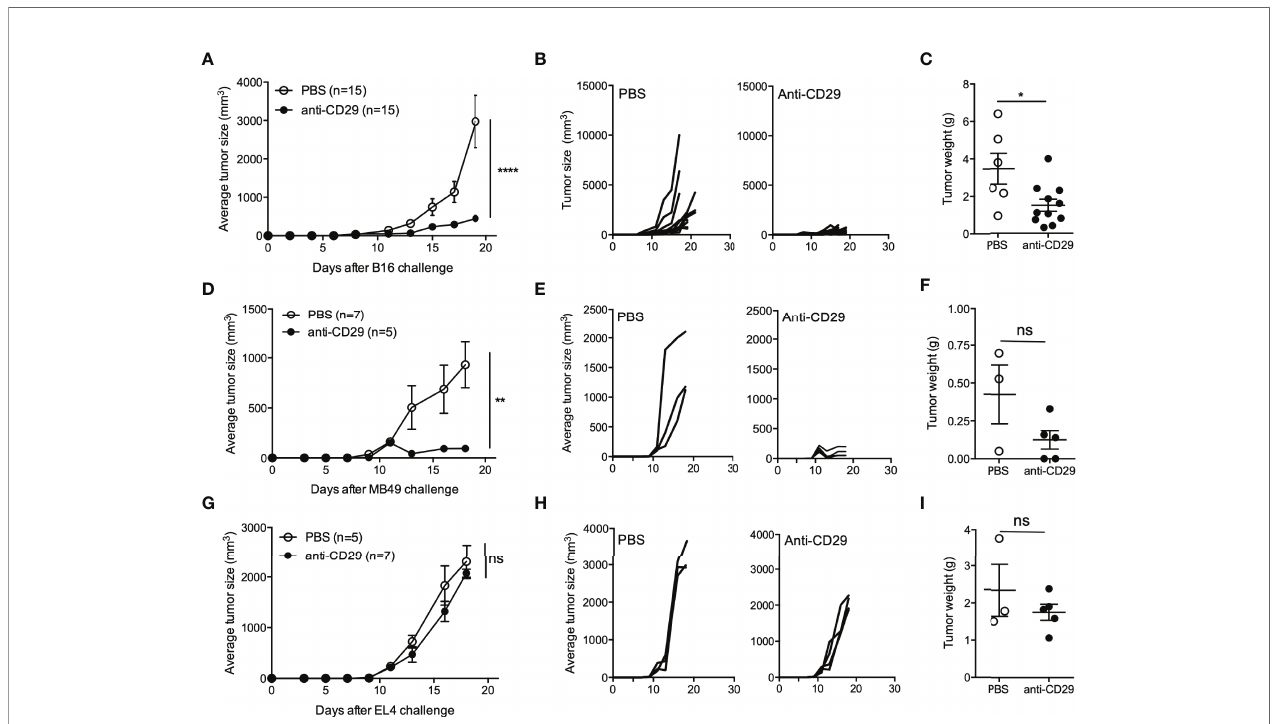
FIGURE 4 | The blockade of CD49b/CD29 axis inhibits tumor growth. A total of 2 × 10 5 B16, MB49, or EL-4 cells were injected into the right fl ank of C57BL6 GFP reporter mice. One hundred microliters of PBS 1× containing 200 ng of anti-CD29 antibody, or PBS alone as control, were administered to tumor-bearing animals when the tumors became palpable (approximately day 9 post-tumor inoculation). The treatment was given three times per week. At this time point, animals were euthanized for the isolation of TdLNs and tumors. Panels (A – C) depict tumor growth curves, in controls and treated animals, and tumor weight, respectively. The same analysis was carried out for animals inoculated with MB49 cells (D – F) and EL-4 cells (G – I) . For panels (A – C) , plots show data of two to three experiments with n = 5 – 6 animals per group. For panels (D – F) and (G – I) , one to two experiments were performed, with n = 3 – 7 animals per group. For panels (A, D, G) , Mann – Whitney test was applied at the last time point, and for panels (C, F, I) , one-way ANOVA was used. Data are shown as the mean ± SEM. * p < 0.05; ** p < 0.01; *** p < 0.001; **** p < 0.0001; ns, not signi fi